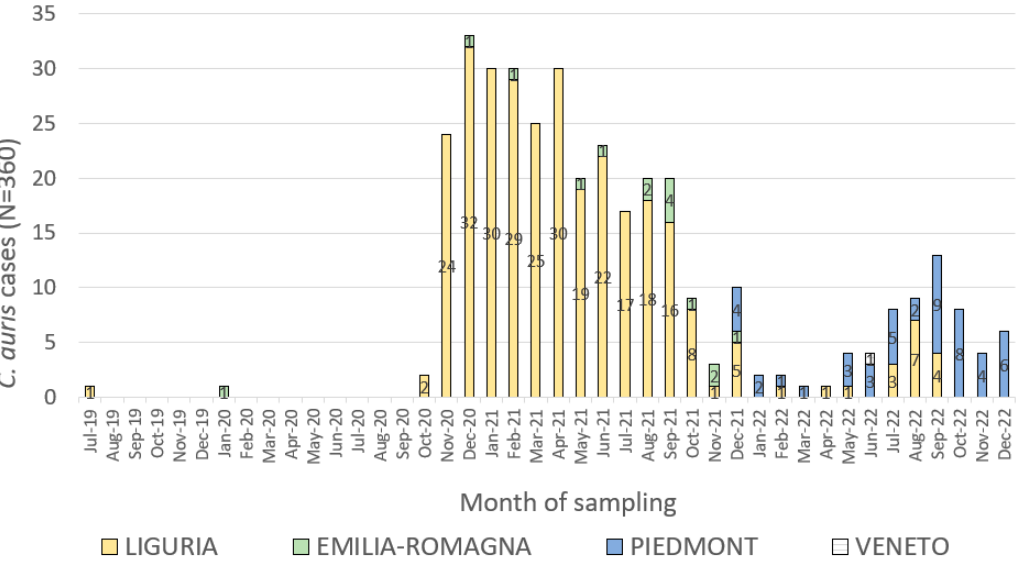
Figure 2. Epicurve of confirmed C. auris cases occurred in Liguria, Piedmont, Emilia-Romagna and Veneto regions by date of sampling and region of residence, Italy, July 2019–December 2022 (N = 360 out of 361 cases).